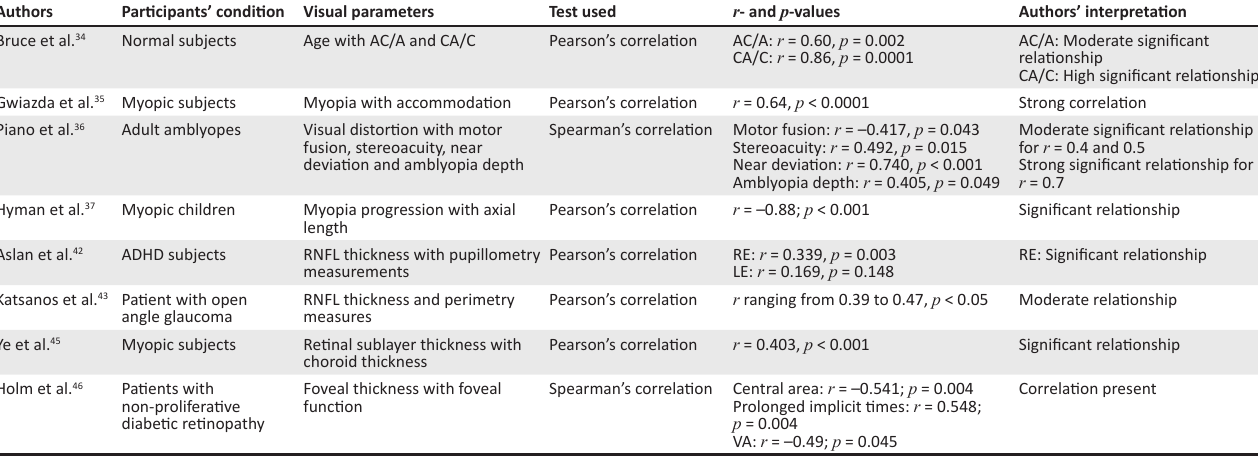
TABLE 2: Studies investigating accommodation, visual distortion, myopia, emmetropisation, retinal nerve fibre layer, choroid using both Pearson’s and Spearman’s correlation coefficients. Authors Participants’ condition Visual